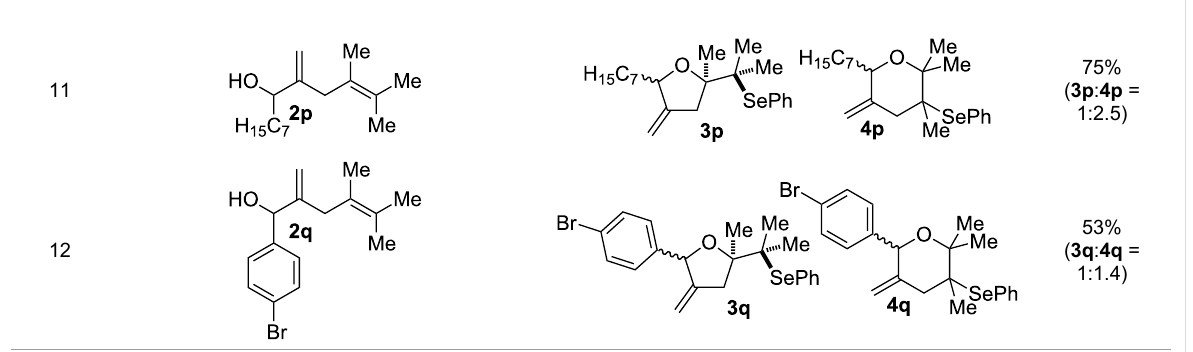
Table 2: Electrochemical selenoalkoxylation of 1,4-dienols 2 a . (continued)